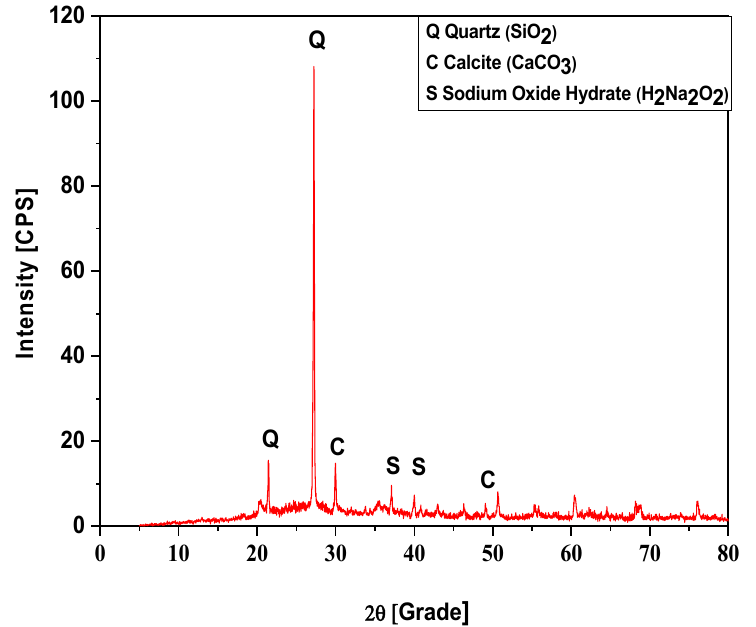
Figure 8. XRD of Si–Al Ash catalyst pellets.